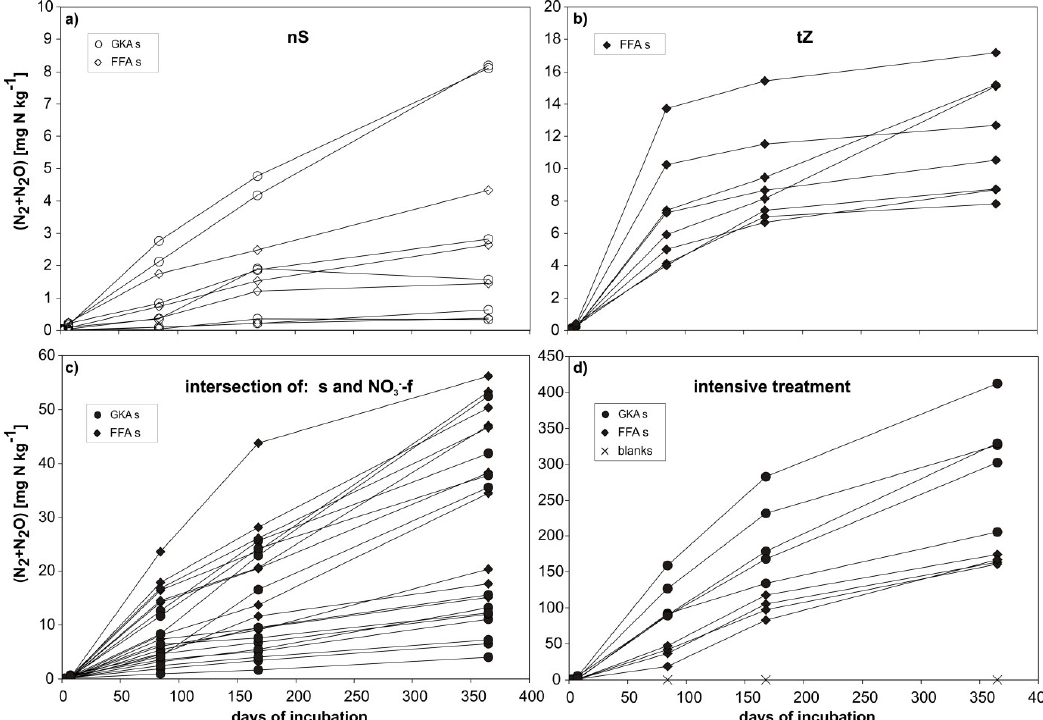
Fig. 1. Time courses of denitrification products (N 2 + N 2 O) (average of 3 to 4 replicas per depth) from different groups of aquifer material during standard (a–c) and intensive treatment (d) . Open and closed symbols denote non-sulphidic and sulphidic aquifer material, respectively. Circuits and diamonds represent GKA and FFA material, respectively. Crosses indicate blanks of intensive treatment. nS, S, tZ and NO − f indicate non-sulphidic and sulphidic samples, transition zone material and NO − clarity, but were small in comparison to measured concentrations of denitrification derived (N 2 + N 2